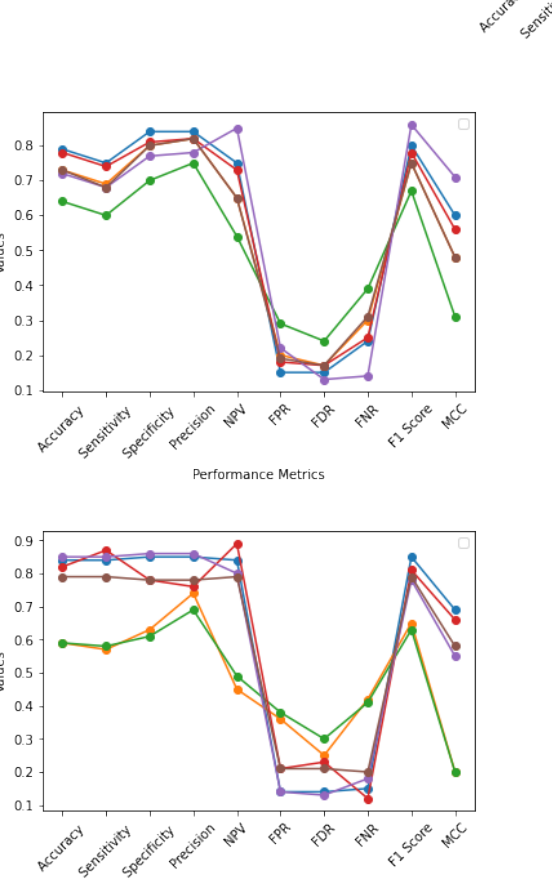
Figure 4. The graphs illustrate the Accuracy, Specificity, Sensitivity, Precision, Recall, F1 Score, NPV, FPR, FDR, FNR, and MCC of AlexNet, ResNet, SVM, LeNet, LIM, and CNN-DNN for five-fold, eight-fold, and generalization approach, respectively, with values ranging from − 1 to